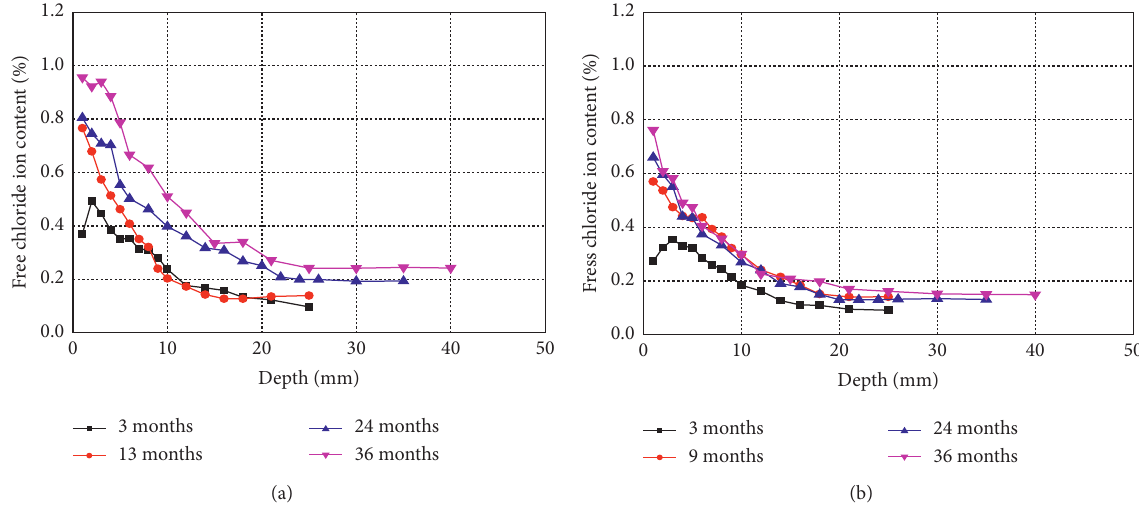
Figure 5: Free chloride ion content exposed to marine submerged zone for 36 months (a). OPC